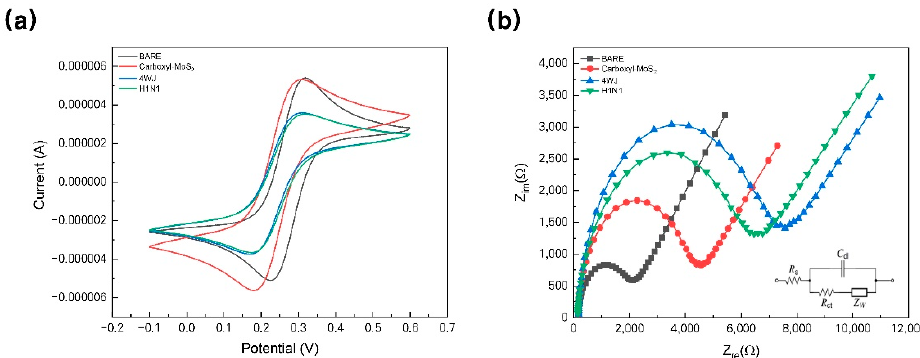
Figure 4. ( a ) Cyclic voltammogram of Au (black line), Au/carboxyl-MoS 2 (red line), Au/carboxyl-MoS 2 /4WJ (blue line), and Au/carboxyl-MoS 2 /4WJ/HA protein (green line) in 5 mM [Fe(CN) 6 ] 3 − /4 − solution in 10 mM HEPES (pH 7.04) containing 1 M KCl at a scan rate of 50 mV/s. ( b ) Impedance spectra of Au (black line), Au/carboxyl-MoS 2 (red line), Au/carboxyl-MoS 2 /4WJ (blue line), and Au/carboxyl-MoS 2 /4WJ/HA protein (green line) in 5 mM [Fe(CN) 6 ] 3 − /4 − solution in 10 mM HEPES (pH 7.04) containing 1 M KCl; the frequency range was from 100 kHz to 1 Hz at a DC potential of 0.25 V. 4WJ, four-way junction.